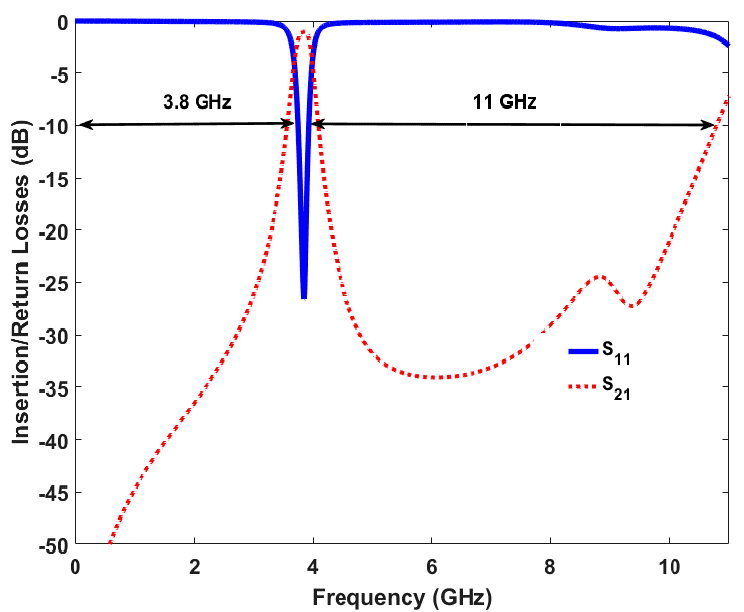
Figure 4. Theoretically calculated coupling coefficient performance of the presented three-pole planar BPF.